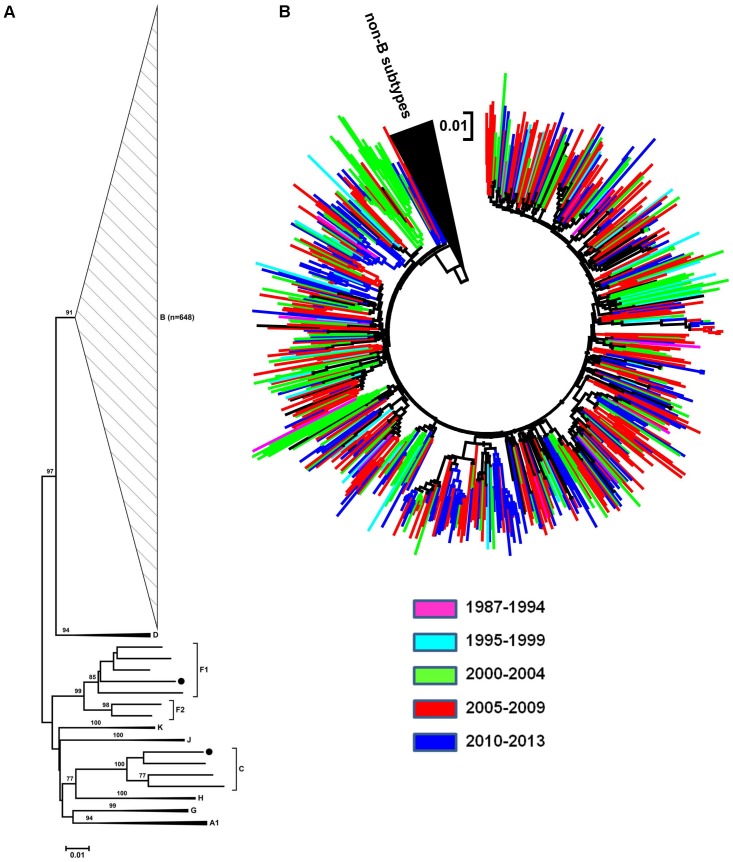
Phylogenetic Neighbor-Joining tree of HIV pol gene sequences from Panamanian infected subjects sampled from 2007 to 2013.(A) Panamanian HIV (black circles) are clustered with highly support within the clade of subtype B (n = 648), subtype F1 (n = 1) and subtype C (n = 1) reference sequences. For clarification purposes, branches have been compressed by each subtype. Bootstrap values higher than 80 are shown at branches. (B) Clustering of subtype B sequences defined by colored range of diagnostic age.